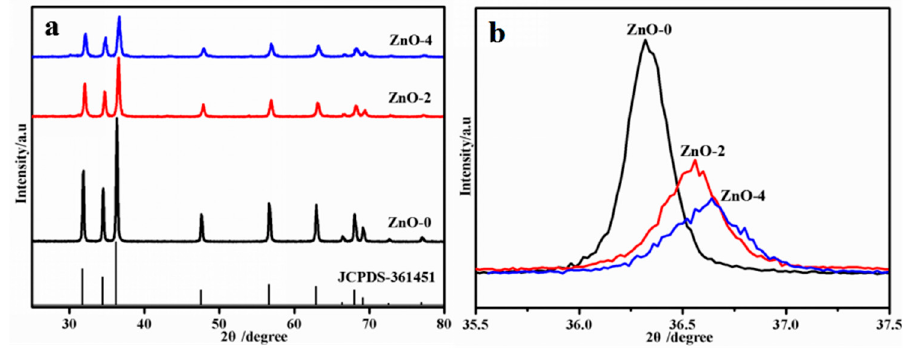
Figure 1. XRD patterns ( a ) and the local amplification ( b ) of the samples ZnO-0, -2 and -4.